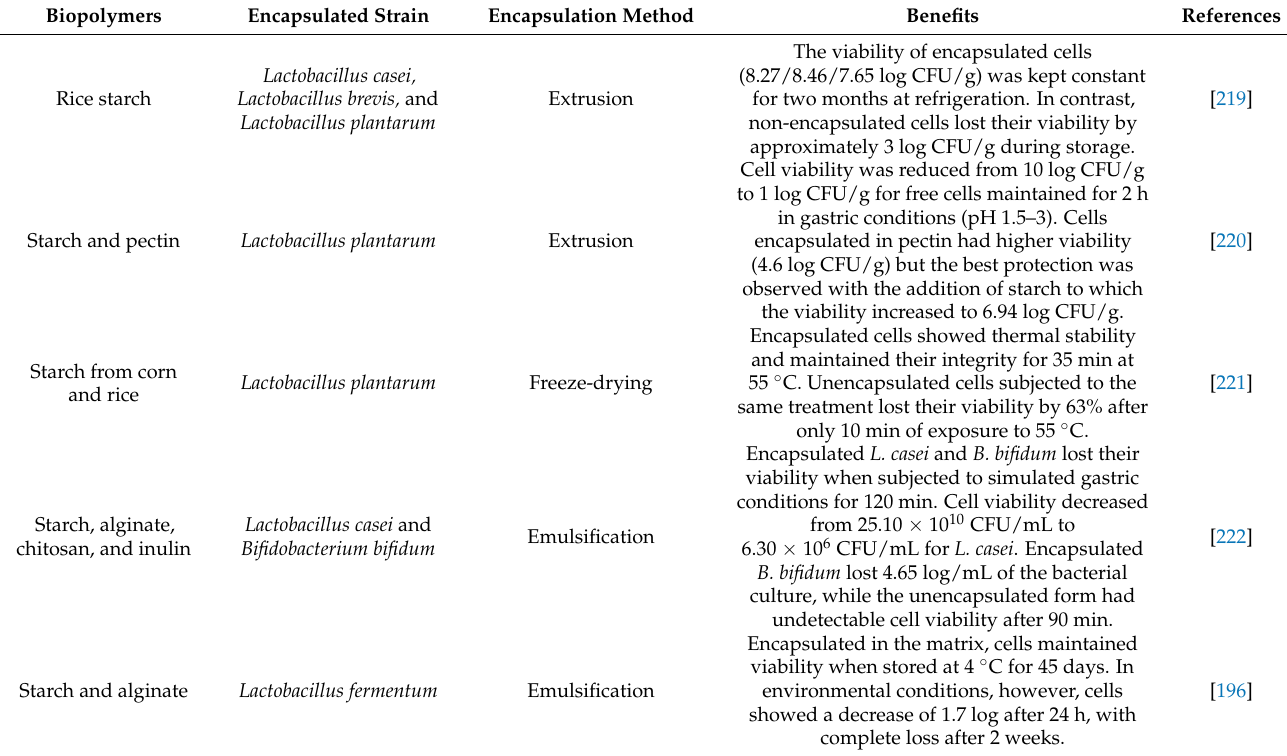
Table 7. Starch as an encapsulation material for